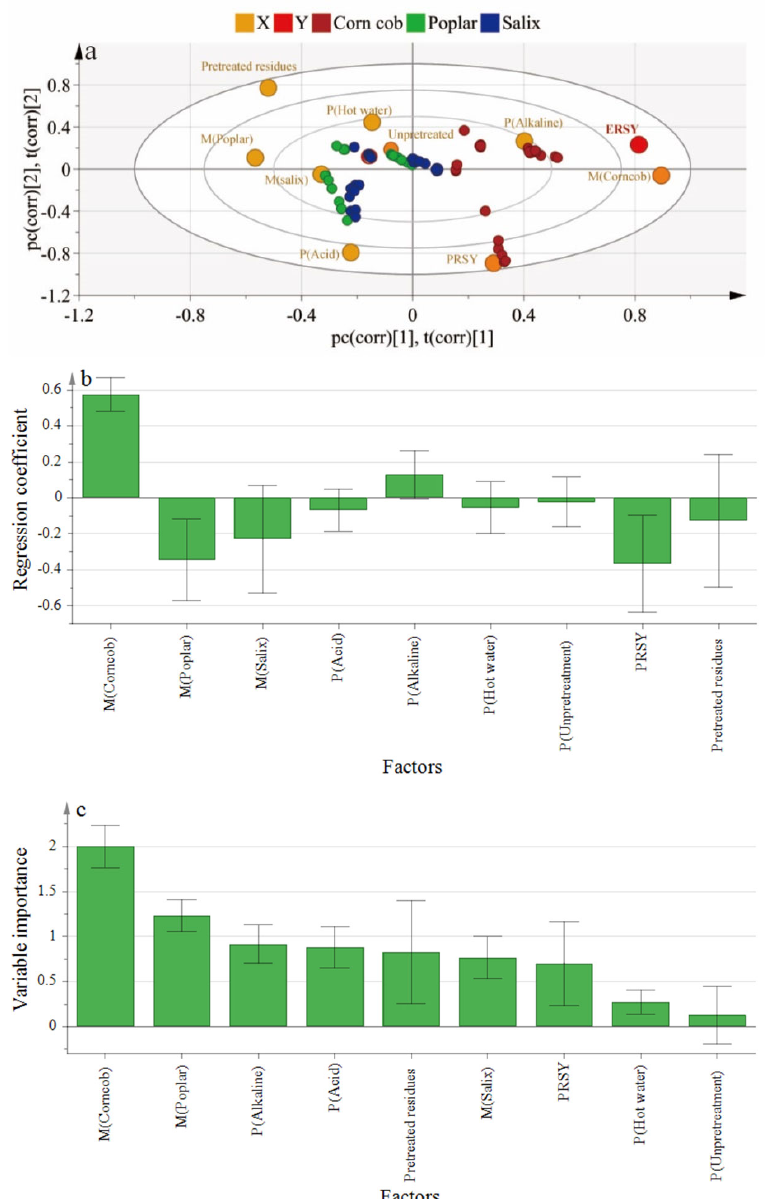
Figure 2. PLS model 1 analysis for the effects of biomass type and pretreatments on the ERSY. ( a ) Biplot. ( b ) Regression coefficients of X variables on the Y variable. ( c ) Importance of X variables on the Y variables for the projection. Note: ( a ) The poplar, salix and corn cob were the pretreated samples under different experimental conditions. The scores t[1] and t[2] summarize the X variables, which are orthogonal and completely independent of each other. The score t[1] (first component) explains the largest variation of the X space, followed by t[2]. The regular loading values p correspond to the covariances between the X variables and the score vectors (t) in question, which mean that the magnitude (numerical range) of each X variable is reflected in the loading value. The weights of the variables were indicated by pc[1] (for the first component) and pc[2] (for the second component). The error bars mean the confidence intervals of the coefficients, which indicate the influence degree of each variable, and the influence is significant when the confidence intervals do not include